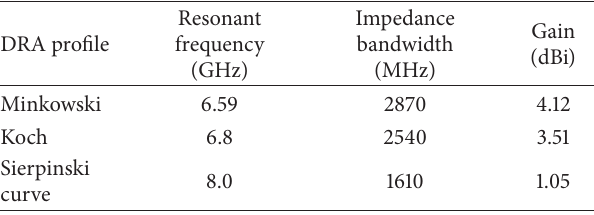
Table 5: Numerically Simulated Characteristics of fractal-based DRAs as Reported in [50].